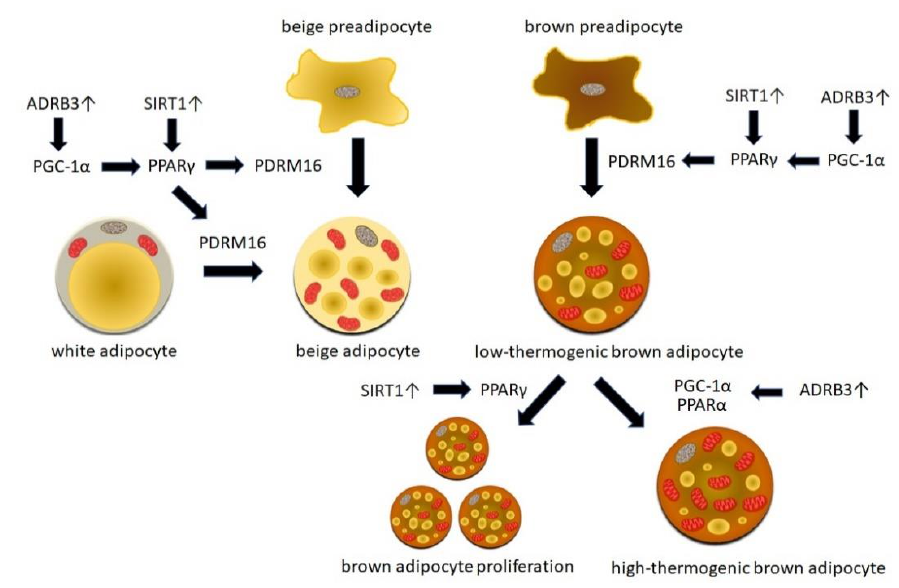
Figure 1. Selected molecular mechanisms involved in white adipose tissue browning and brown adipose tissue activation that could constitute potential therapeutic targets for obesity treatment. Stimulation of adrenergic receptors β 3 (ADRB3) is crucial for the initiation of thermogenic pathways, leading to the induction of proliferator-activated receptor gamma (PPAR γ ) coactivator 1 α (PGC-1 α ) and PPAR γ . Sirtuin 1 (SIRT1) also activates PPAR γ and enables the recruitment of PRDM16 (PR domain containing 16) transcription factor and initiation of the brown fat specific program. These mechanisms regulate the di ff erentiation of beige progenitors toward mature beige adipocytes and the transdi ff erentiation of white to beige adipocytes. Stimuli activating ADRB3 and SIRT1 are also involved in brown adipocyte di ff erentiation, proliferation, and activation leading to the change from the low-thermogenic toward the high-thermogenic phenotype.